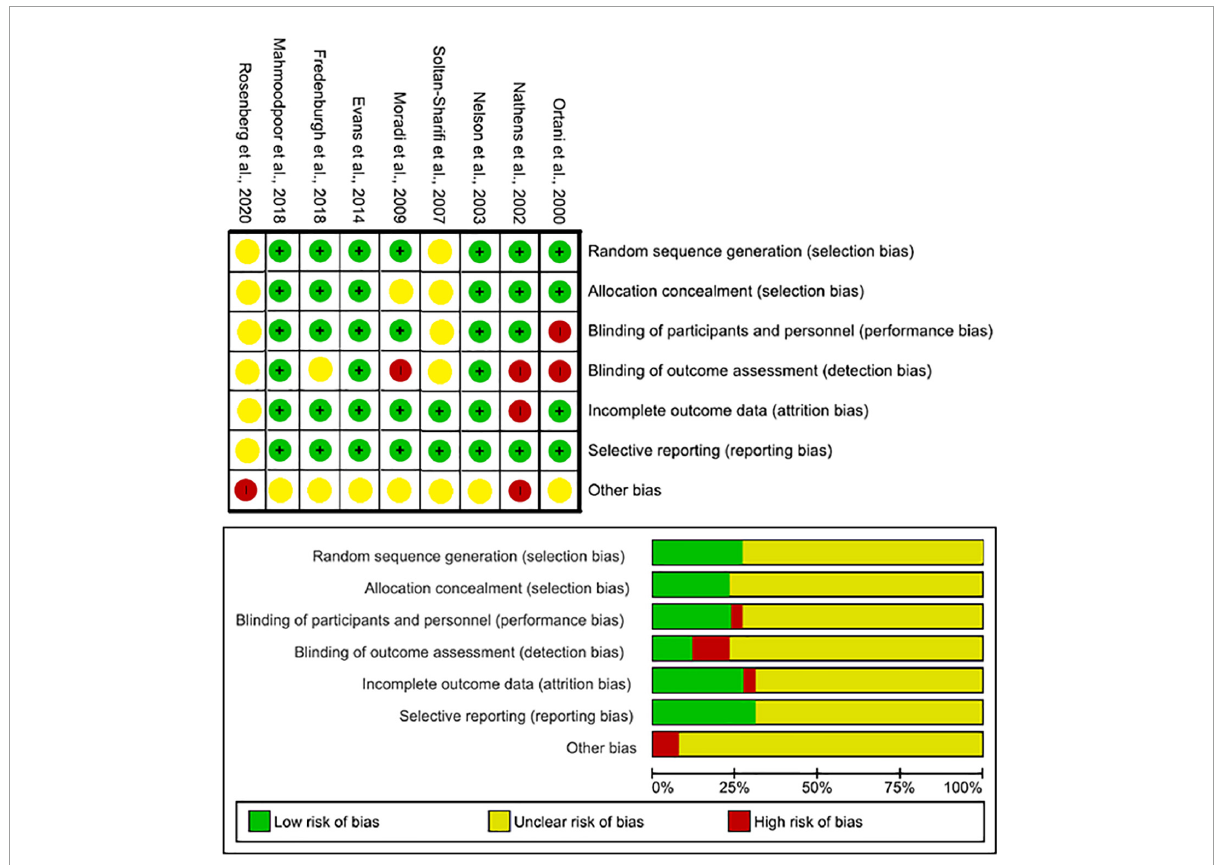
FIGURE4 Quality assessment Cochrane risk of bias for RCT trial